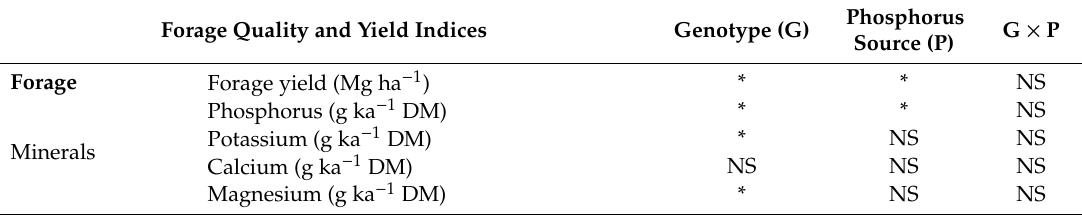
Table 5. Analyses of variance (ANOVA) regarding forage yield and quality indices of silage-corn genotypes under organic and inorganic